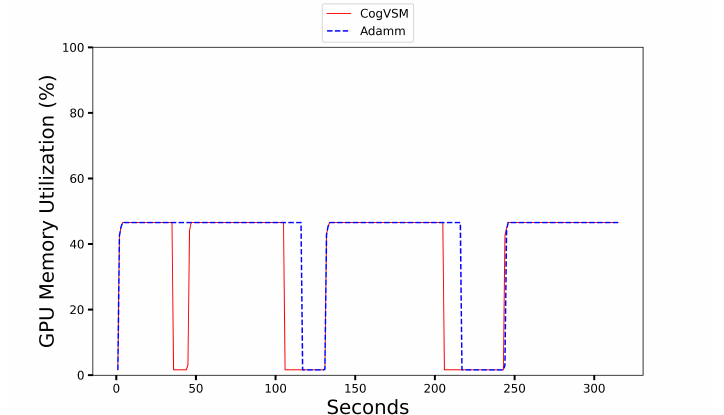
Figure 8. GPU memory utilization on an urban area video of the proposed CogVSM framework compared to the AdaMM framework ( θ m = 10 s for AdaMM).